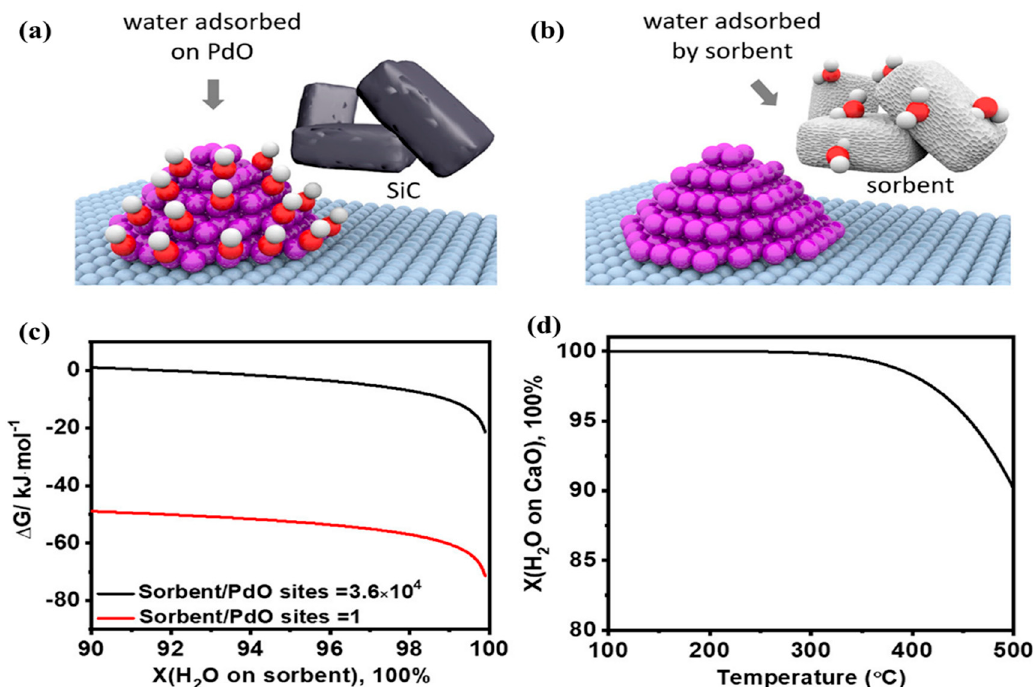
Figure 15. Schematic of sorption on either PdO or sorbent surface depending on the conditions: ( a ) reaction with SiC as an inert diluent where the activity slows as water produced adsorbs on PdO surfaces at high coverage and ( b ) one with a water sorbent where methane combustion occurs on active PdO surfaces with low water coverage; ( c ) required Gibbs free energy change of water sorption on a sorbent as a function of the percentage of water adsorbed by the sorbent; ( d ) fraction of water absorbed on CaO as a function of temperature. Reprinted with permission from Ref . [109].